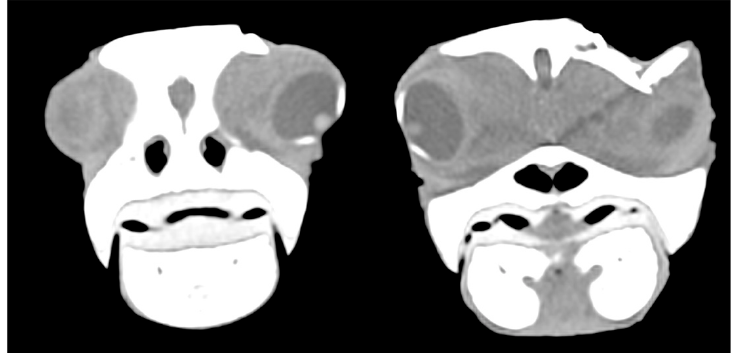
Figure 8. CT scan showing the displacement of the eyeball downwards due to the pressure of the surrounding tissue and fractured postorbital